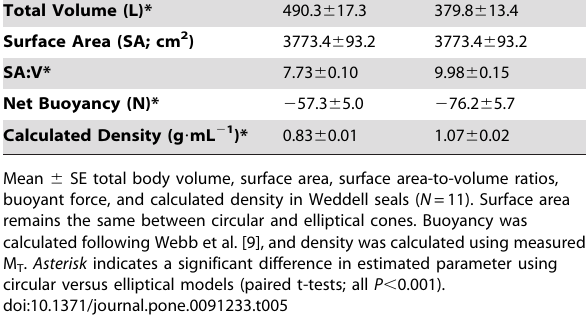
Table 5. Differences in additional physiological parameters determined by circular vs. elliptical truncated cones. Physiological Estimate Circular Cones Elliptical